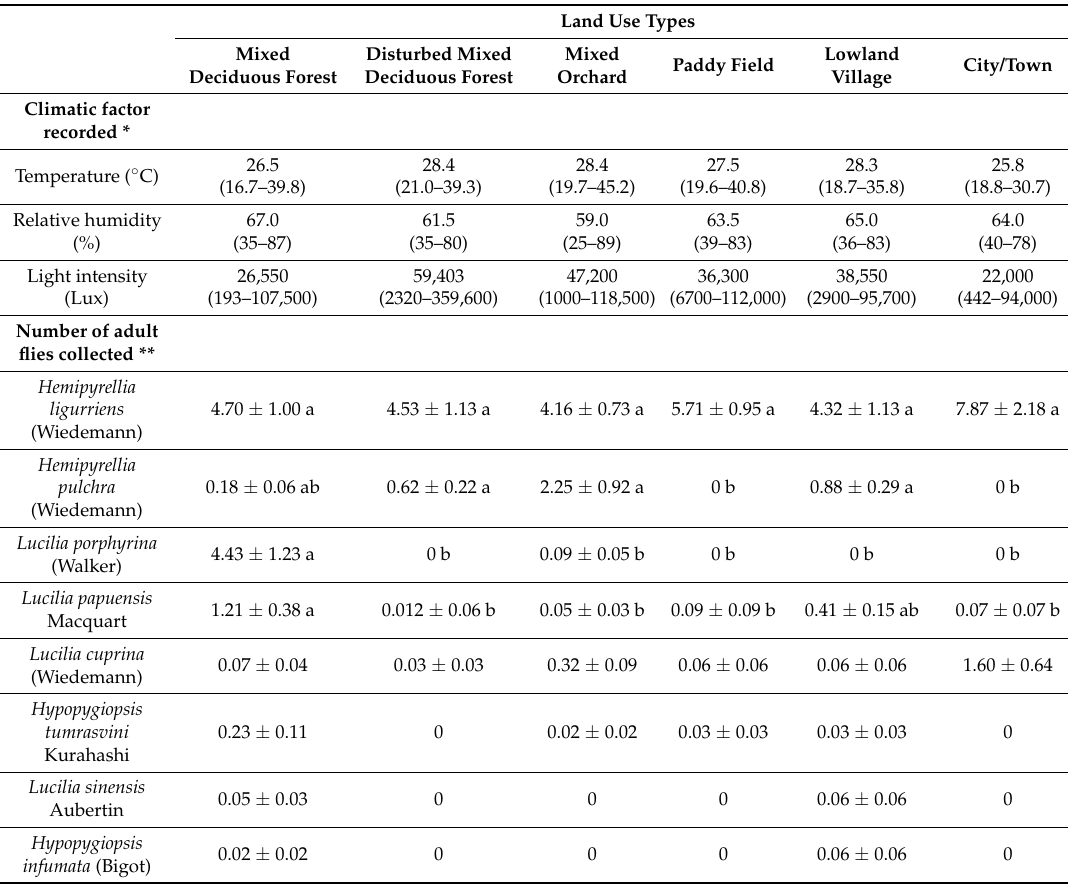
Figure 2. Monthly fluctuations in trap catches of H. ligurriens , L. porphyrina , H. pulchra , and L. papuensis determined using a portable funnel trap baited with one-day-old beef offal in Chiang Mai Province, northern Thailand, May 2009 to May 2010 ( A ), and variation of temperature and relative humidity recorded during the fly survey ( B ). Table 1. Climatic factors (temperature, relative humidity, and light intensity) recorded and total numbers of Luciliinae flies collected at each land use